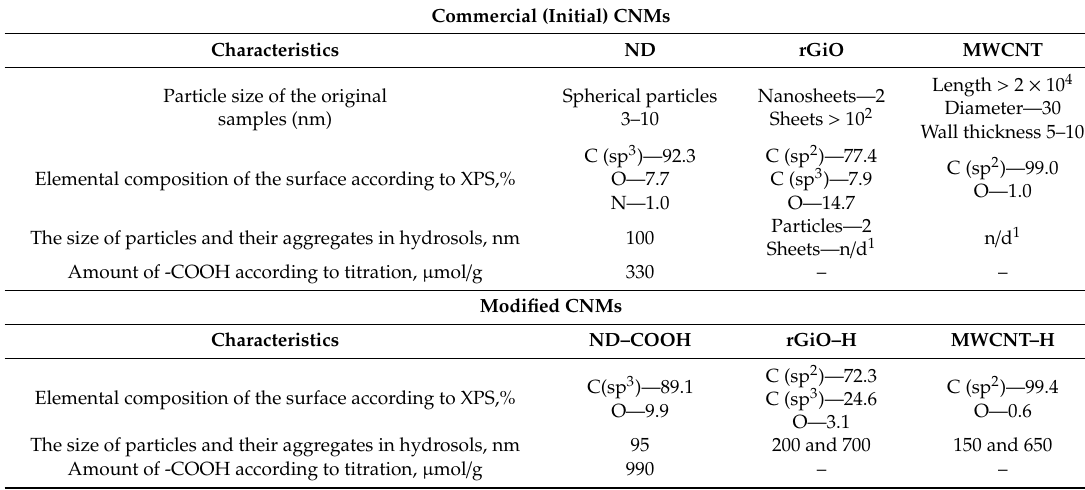
Table 1. Characterization of carbon nanomaterials